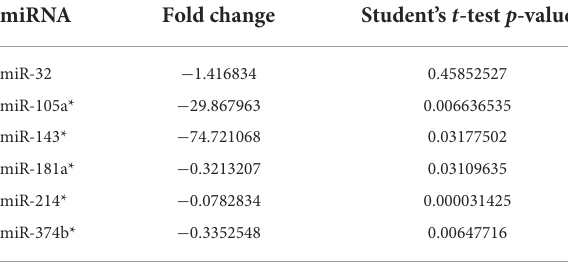
TABLE 3 RT-qPCR evaluation of a selected differentially expressed miRNAs on the RNA-Seq evaluation. miRNA Fold change Student’s t -test p